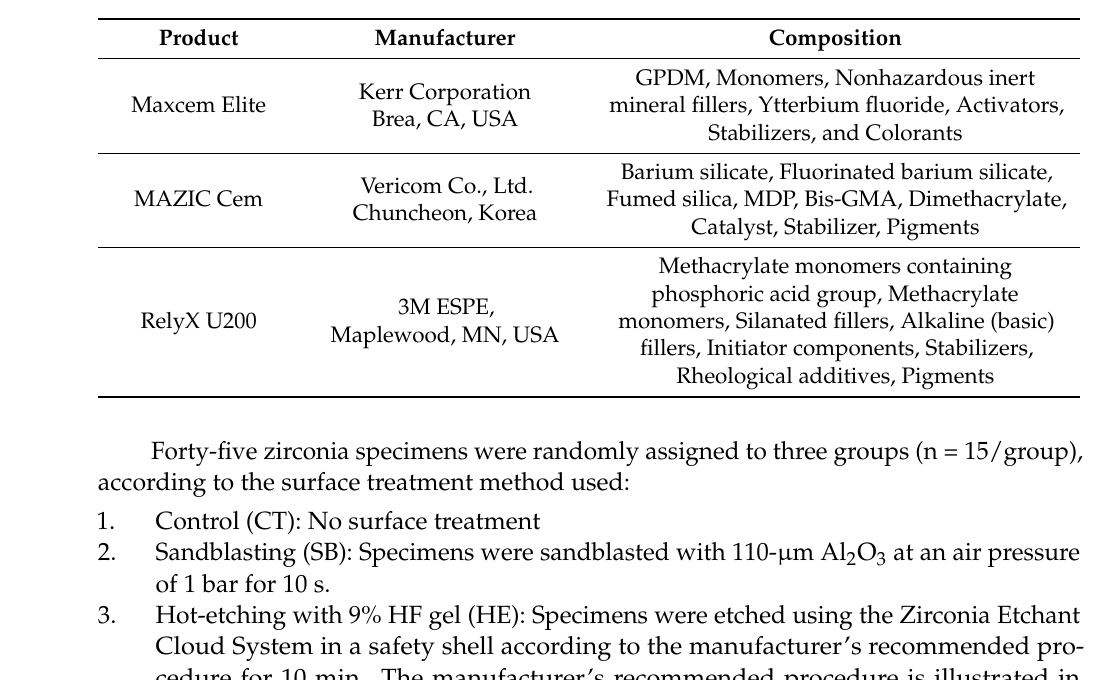
Table 1. Resin cements used in this study.